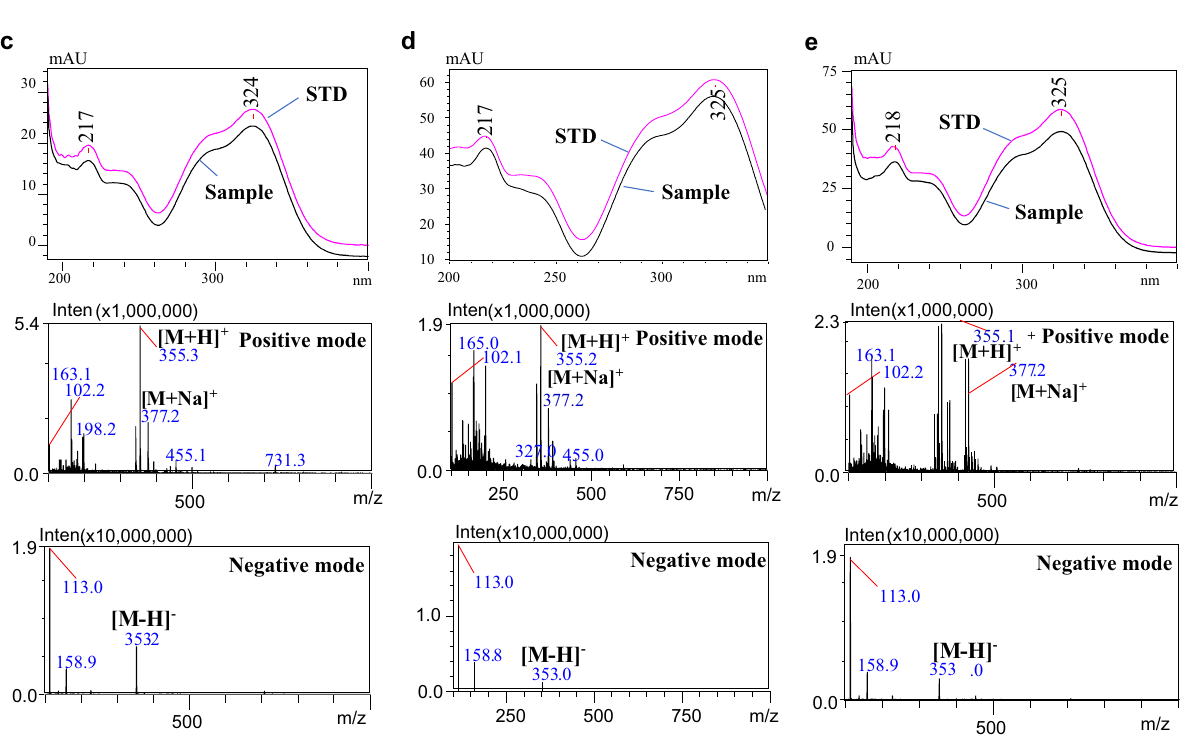
Figure 3. Major compound alteration by bioconversion of MLE using Pectinex. ( a ) Chemical structure of the three main compounds. ( b ) HPLC chromatogram of the standard mixture (STD), MLE and BMLE. #1, neochlorogenic acid (5-CQA); #2, chlorogenic acid (3-CQA); #3, cryptochlorogenic acid (4-CQA). UV and MS spectra of three main compounds in sample: ( c ) 5-CQA, ( d ) 3-CQA and ( e )